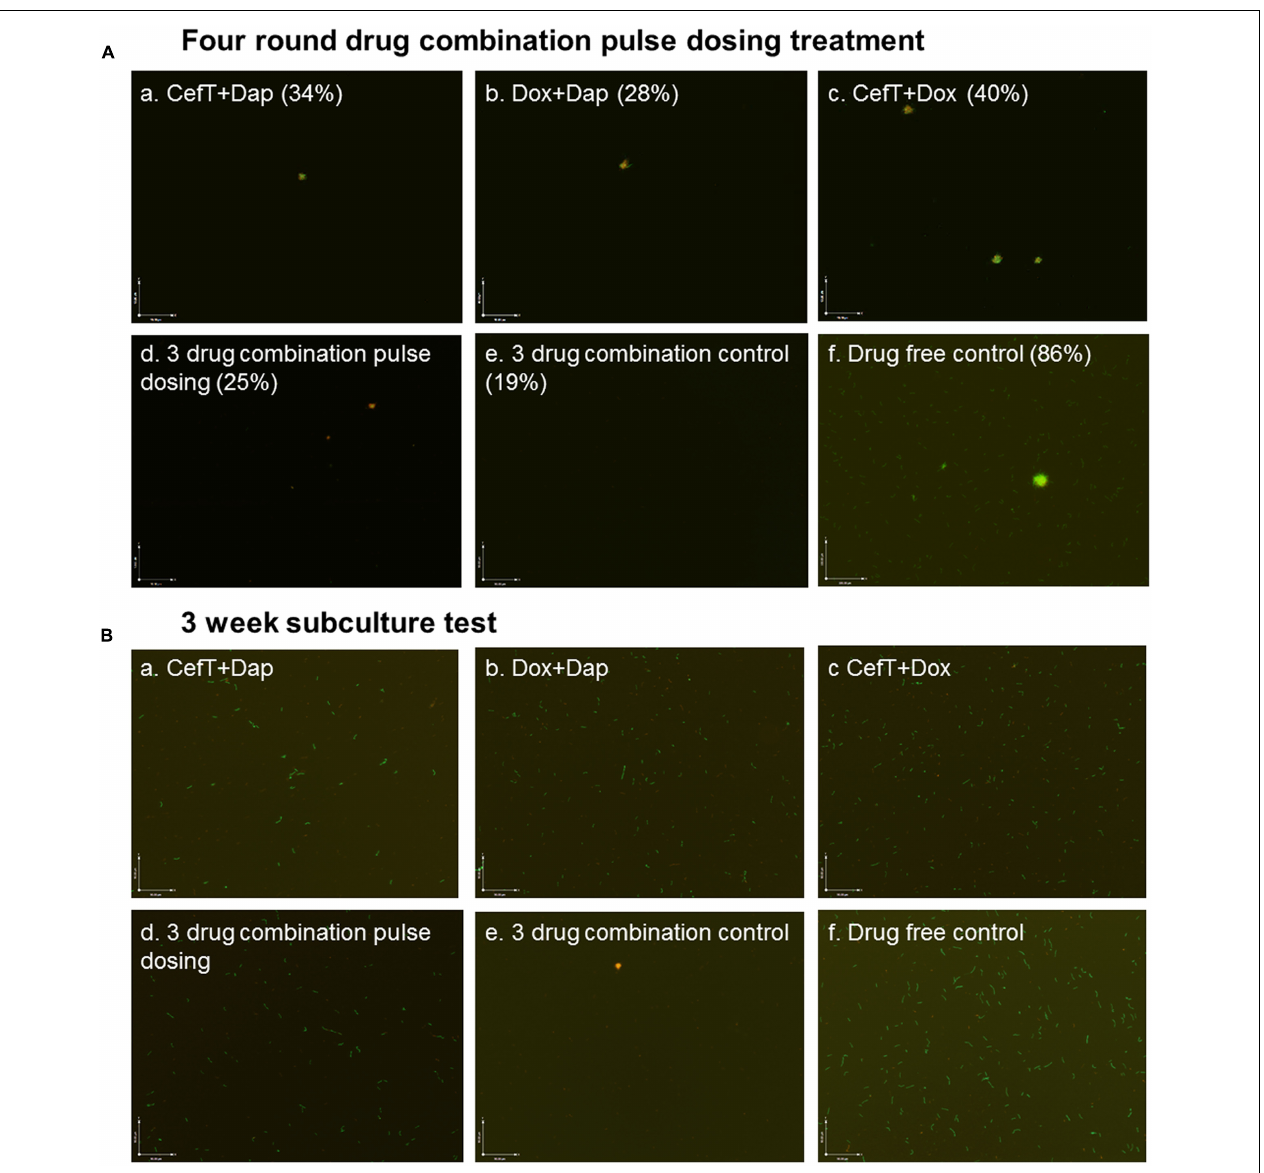
FIGURE 3 | Representative images of a 10 day old B. burgdorferi stationary phase culture treated with drug combination pulse dosing treatment (Aa–f) and subcultured for 21 days in fresh BSK-H medium (Ba–f) . Stationary phase B. burgdorferi culture (10 day old) was treated with pulse dosing treatment of two drug combinations (CefT + Dap; Dox + Dap, CefT + Dox) or the three drug combination (ceftriaxone/doxycycline/daptomycin; 5 µ g/ml) followed by staining with SYBR Green I/PI assay and fluorescence microscopy at 100 × magnification. The percentage of residual viable cells is shown in brackets. The percentage of residual viable cells was calculated according to the regression equation and green/red fluorescence ratios as described in the section “Materials and Methods.” Abbreviations: CefT, ceftriaxone; Dox, doxycycline; Dap,